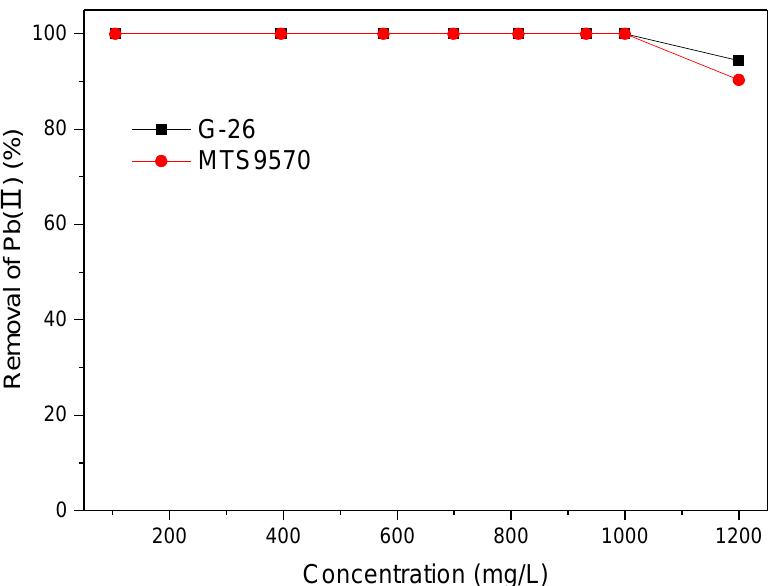
Figure 7. Effect of initial metal concentration on adsorption of Pb(II) onto G-26 and MTS9570 reins at 0.5 g of resin dosage, 20 min agitation time, 150 rpm agitation speed, pH 3.5, and temperature 20 °C.